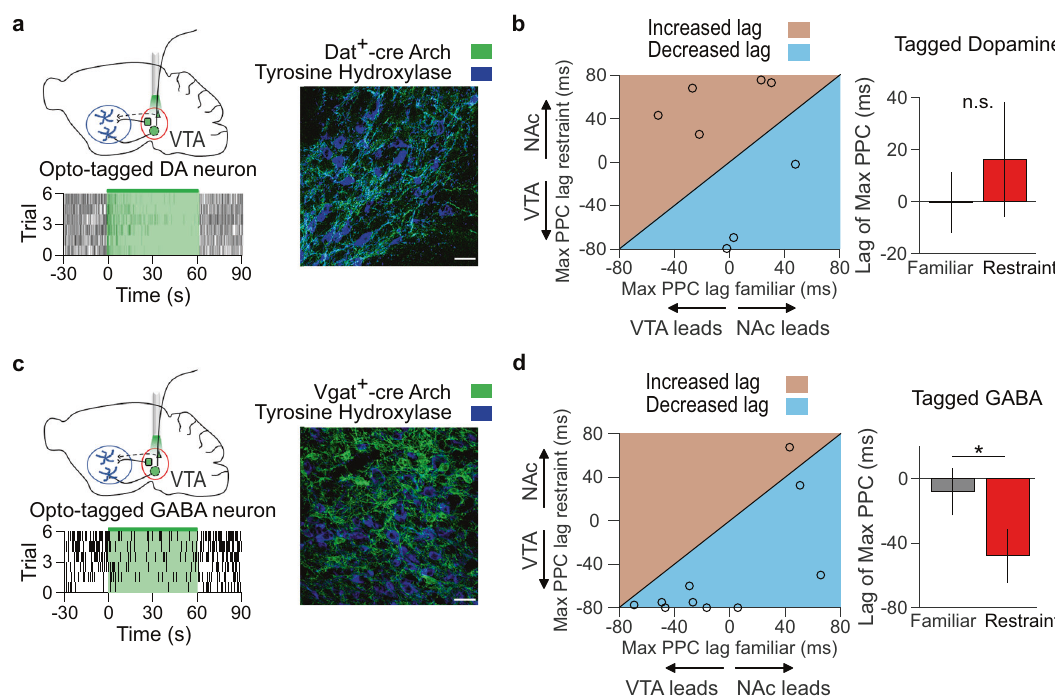
Fig. 4 VTA GABA activity leads to low-frequency NAc oscillations during restraint. a Top left: experimental design. Bottom left: raster plot of opto- tagged DA neuron. Right: immuno fl uorescent image of archaerhodopsin (Arch) expression (green) in a Dat-ires-Cre mouse VTA, with tyrosine hydroxylase counterstain (blue). Scale bar is 30 µ m. Representative of 6 experiments. b Left: Relationship between lag of max VTA DA-NAc PPC during familiar environment exploration and restraint, with line of equality for reference. Right: Summary of data from left panel. Restraint did not change the phase-locking direction of the NAc LFP with VTA DA neurons ( P = 0.54, two-tailed paired t test, n = 8 neurons). Data are mean ± s.e.m. c Example raster plot and immuno fl uorescent image from a Vgat-ires-Cre mouse. Scale bar is 30 µ m. Representative of six experiments. d The same as b , but for opto- tagged GABA neurons in a Vgat-ires-Cre mouse. Restraint shifted 4 Hz NAc LFP phase-locking toward past VTA GABA neuron activity (* P = 0.012 two- tailed signed-rank test, n = 10 neurons). Data are mean ±